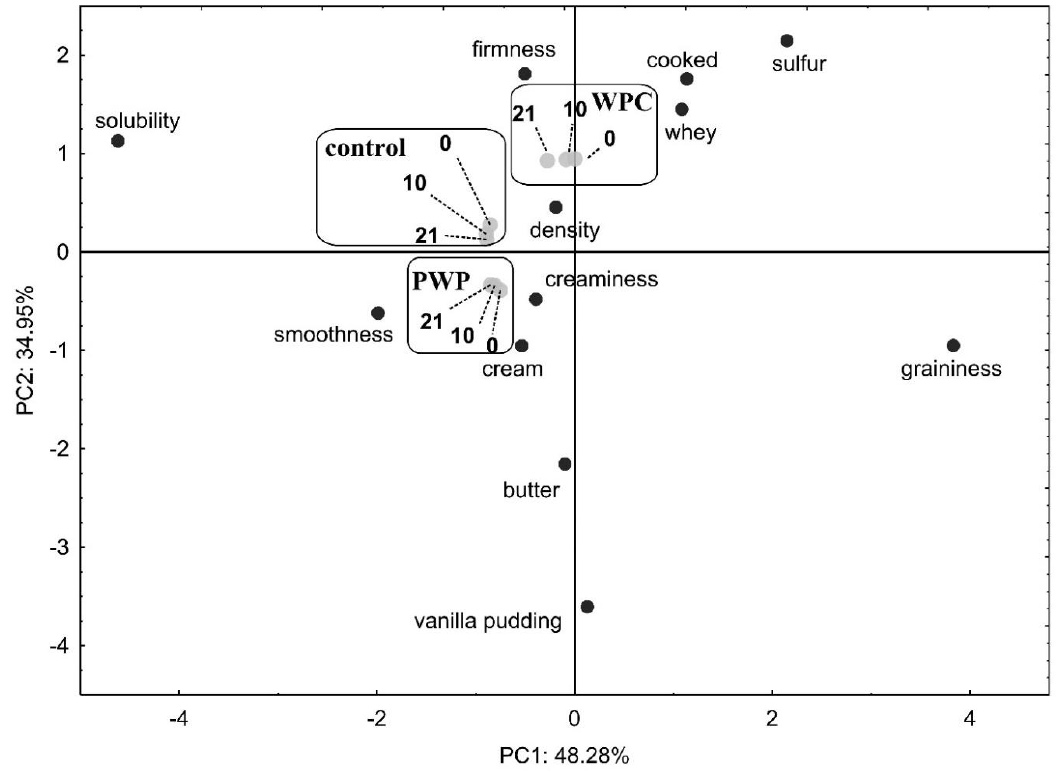
Figure 1. Principal component analysis biplot of sensory parameters used to differentiate yogurt with increased whey proteins content, including whey proteins after the polymerization process. 0, 10, 21, days of cold storage; WPC, yogurt with whey protein concentrate; PWP, yogurt with polymerized whey protein; PC, principal component.